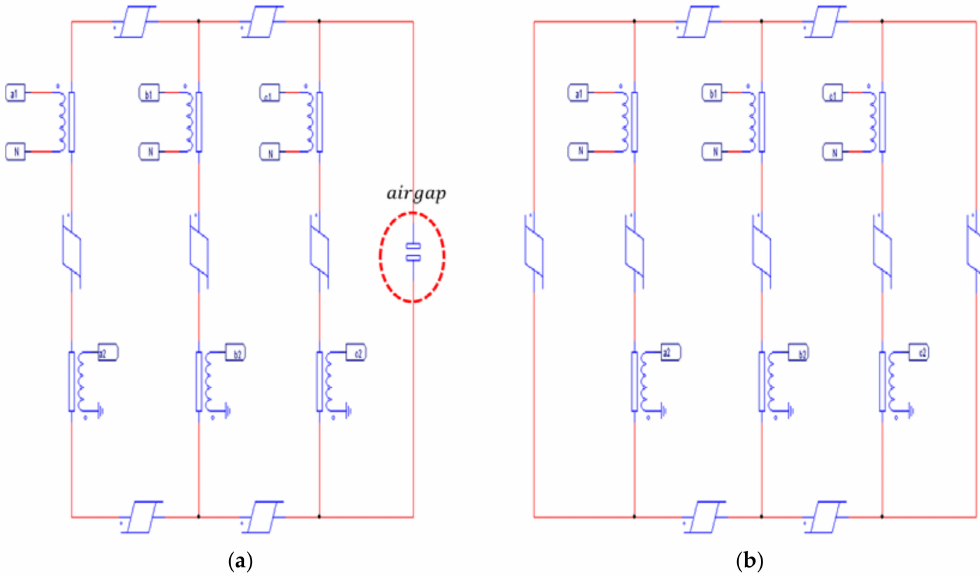
Figure 6. Transformer simulation using PSIM magnetic element: ( a ) three-limb core-type transformer and ( b ) five-limb core-type